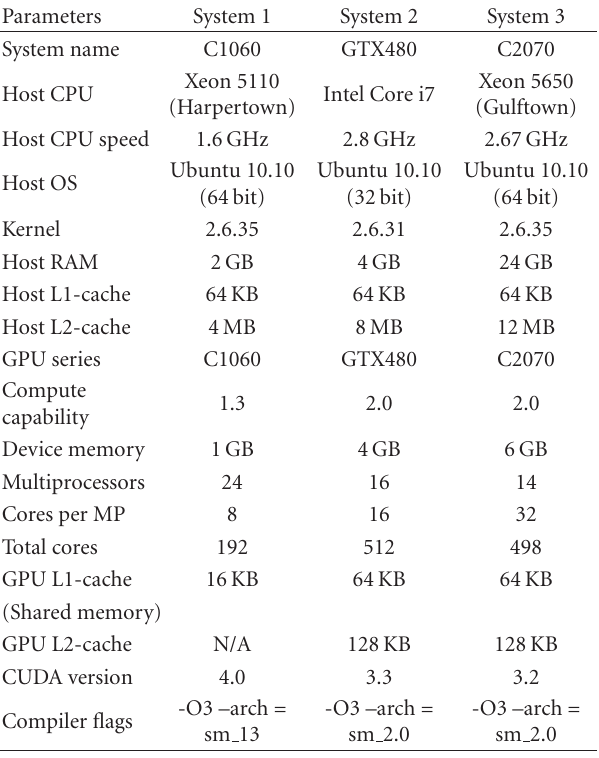
Table 1: Details of systems used for